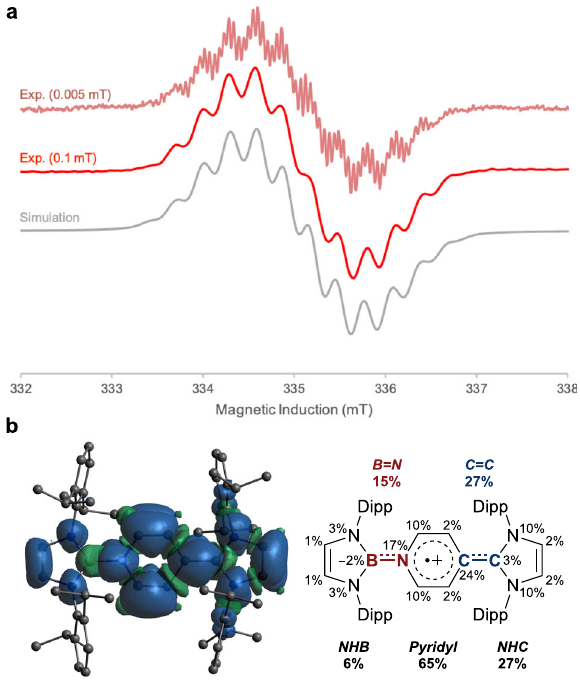
Fig. 5 EPR studies. a Experimental EPR spectra at indicated fi eld modulations (red) and simulation (grey) of 1 • + , detailed in SI. b Calculated spin density. The negative spin densities ( ρ ( α ) − ρ ( β ) < 0), at the boron atom are the result of spin polarization of underlying orbitals by the SOMO. The polarization effect on s-character orbitals results in large Fermi-contact hyper fi ne interactions. A spatial difference in α and β orbitals leads to a change in the overall spin-density